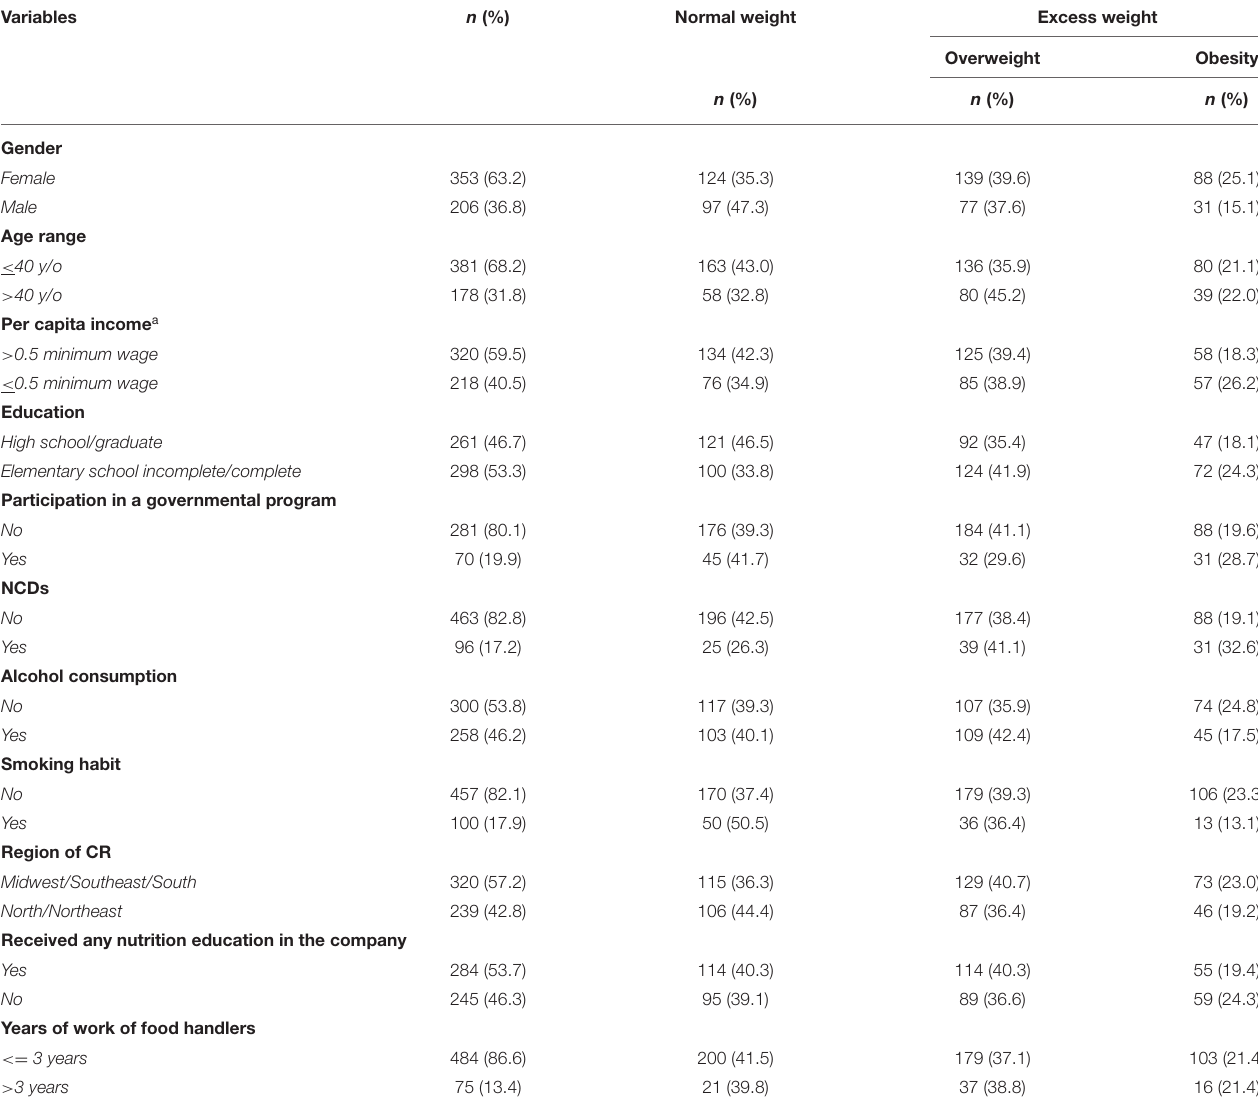
TABLE 1 | Descriptive analysis of socioeconomic, work, and health characteristics and anthropometric status according to body mass index (BMI) among food handlers in Brazilian community restaurants. Variables n (%) Normal weight Excess weight